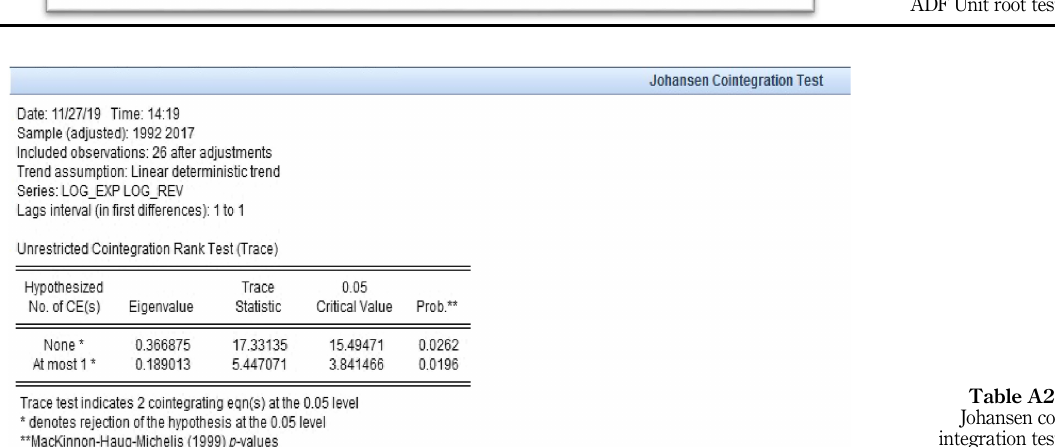
Table A1. ADF Unit root test